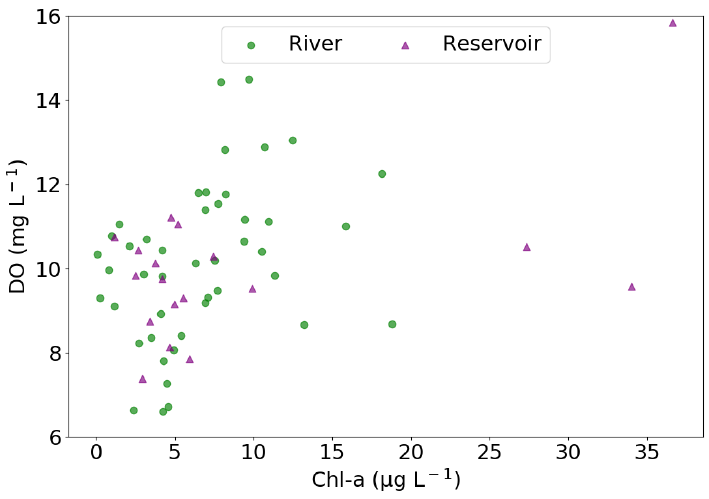
Figure 6. Scatterplot showing the association between Chl-a and DO in rivers and reservoirs of the KRB. The r-value in rivers and reservoirs were 0.35 and 0.55, respectively, and were both statistically significant ( p <